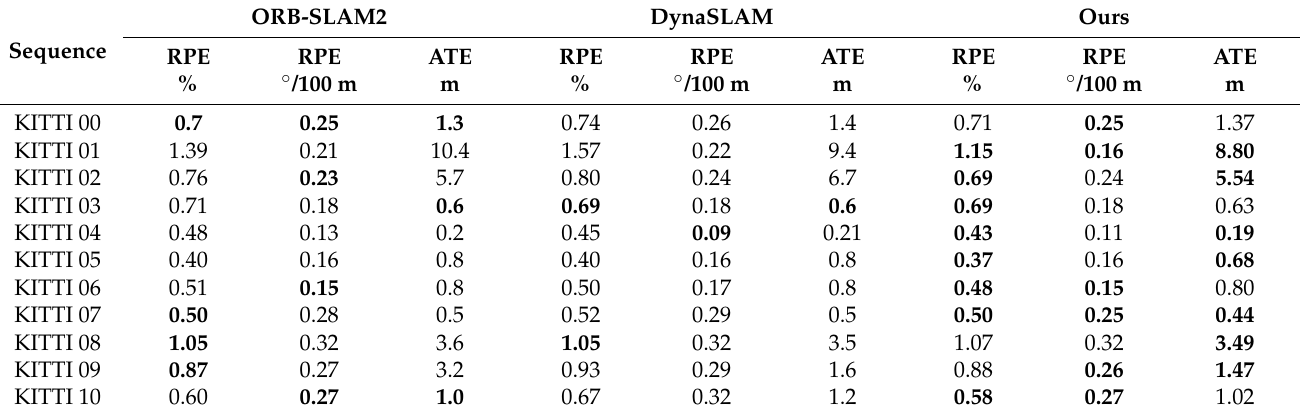
Table 3. Comparison of camera translation trajectory errors under KITTI